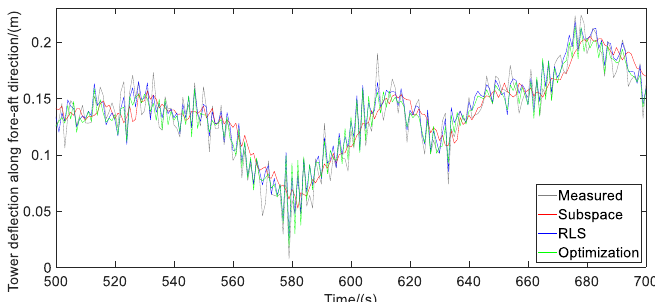
Figure 13. Comparison of tower deflection under scenario Type 2.